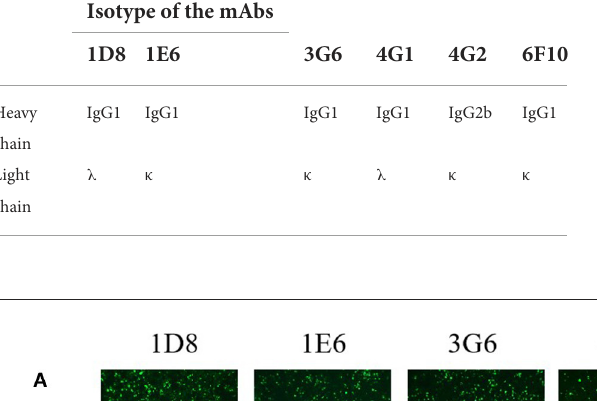
TABLE 2 Identification of the isotype of the mAbs.